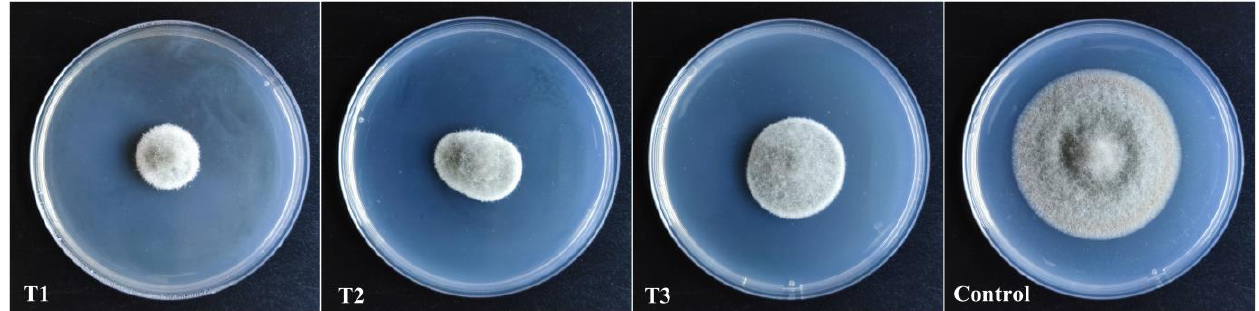
Figure 3. Antifungal activity of different concentration aseptic filtrates against A. alternata on PDA medium after 5 d. T1 (200 mL L − 1 ); T2 (100 mL L − 1 ); and T3 (50 mL L − 1 ); Control (Sterile water treatment).